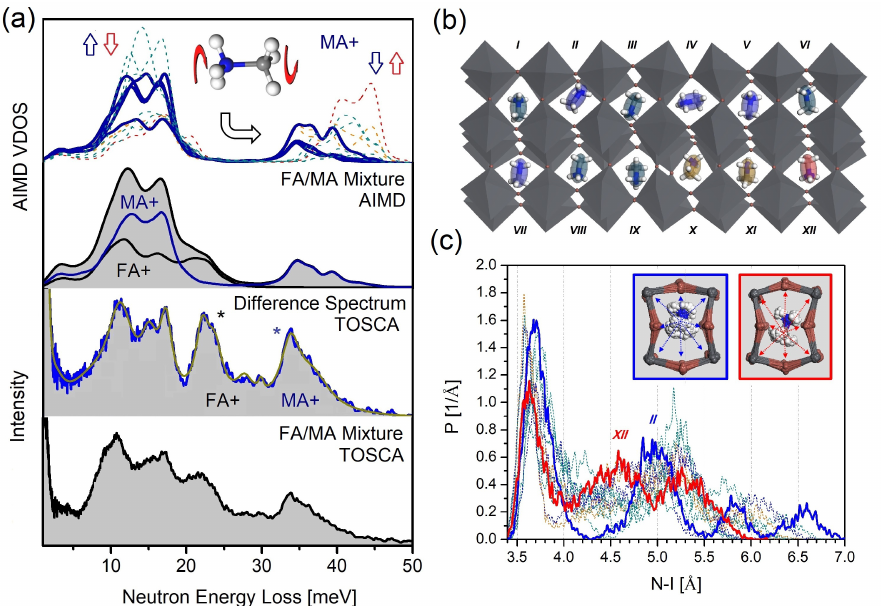
Figure 6. ( a ) The lower two panels show experimental INS spectra of the MA 0.4 FA 0.6 PbI 3 solid- solution recorded on TOSCA+ at T = 10 K, along with the difference spectrum obtained by substract- ing the signal from FAPbI 3 , highlighting contributions from the MA + cations [75]. These data are compared with the results of AIMD simulations in the upper two panels of ( a ). The theoretical INS spectrum of the MA 0.4 FA 0.6 mixed-cation composition was constructed by stoichiometric weighting of the partial hydrogen-projected VDOS. MA + cations were selected based on the analysis of the indi- vidual VDOSs for each of the twelve distinct types used in the structural model (see the bold curves in the top panel). The molecular model in ( a ) illustrates the lowest-energy internal mode of MA + . ( b ) Structural model used to describe the mixture, with FA + omitted to ease visualization. Distinct MA + cations are labeled with Roman numerals. ( c ) Distribution of closest nitrogen-iodine distances for each of the twelve MA + cations. Two extreme cases are highlighted as bold curves (labeled as II and XII ). Their time-evolved structures over a 30-ps interval are presented as cumulative models, as shown in the insets in ( c ). The same color coding has been used in all panels. [Unpublished